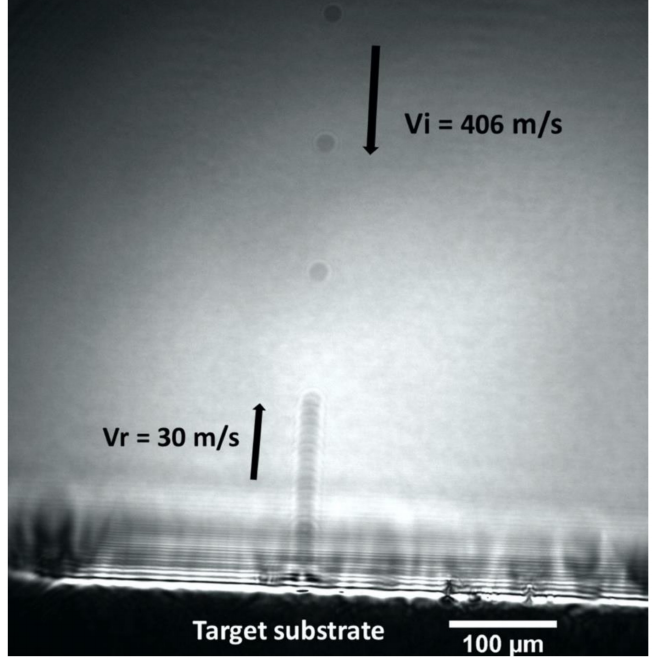
Figure 9. Collision and rebound of the GA Cu particles with a high-purity Al target substrate during advanced LIPIT experimentation. V i and V r are also illustrated in this figure when a V c was not